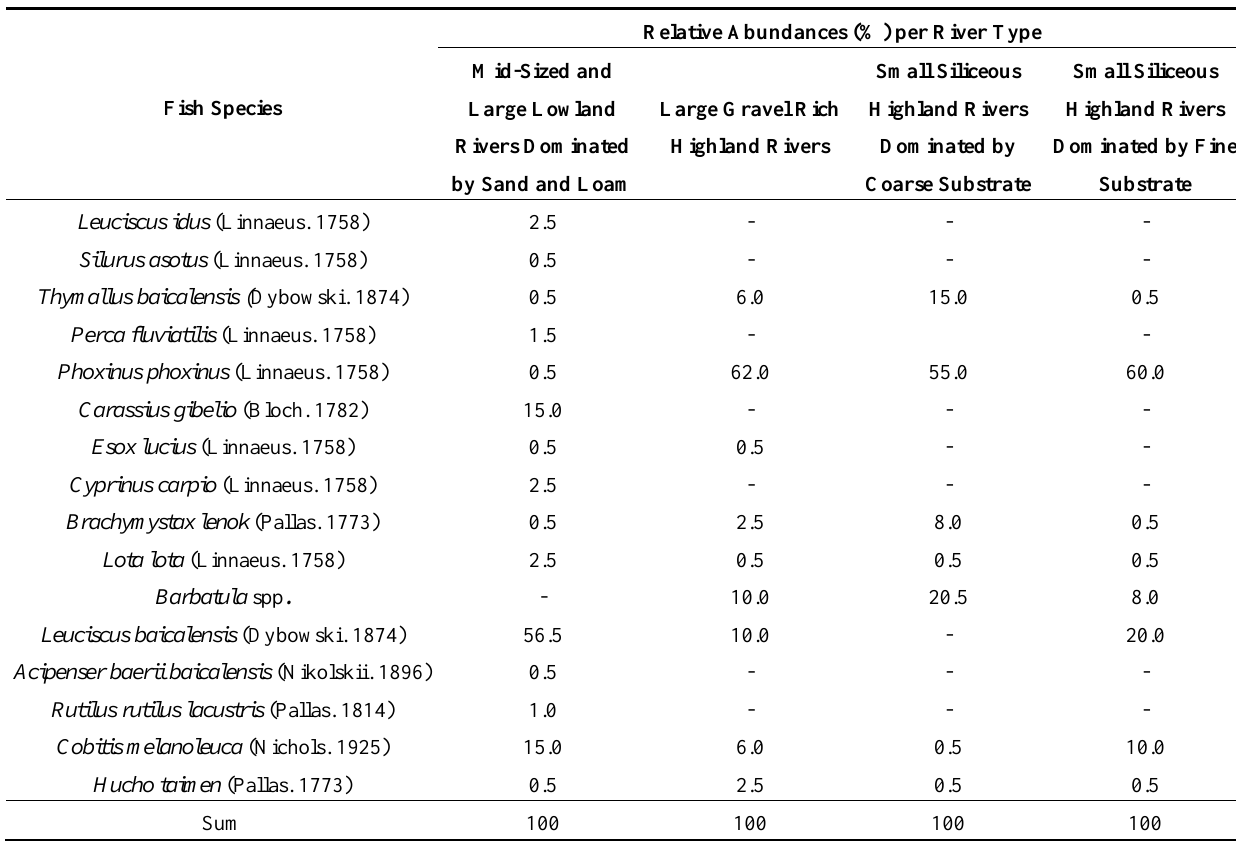
Table 3. Fish species composition used as reference for the ecological assessment of rivers in the